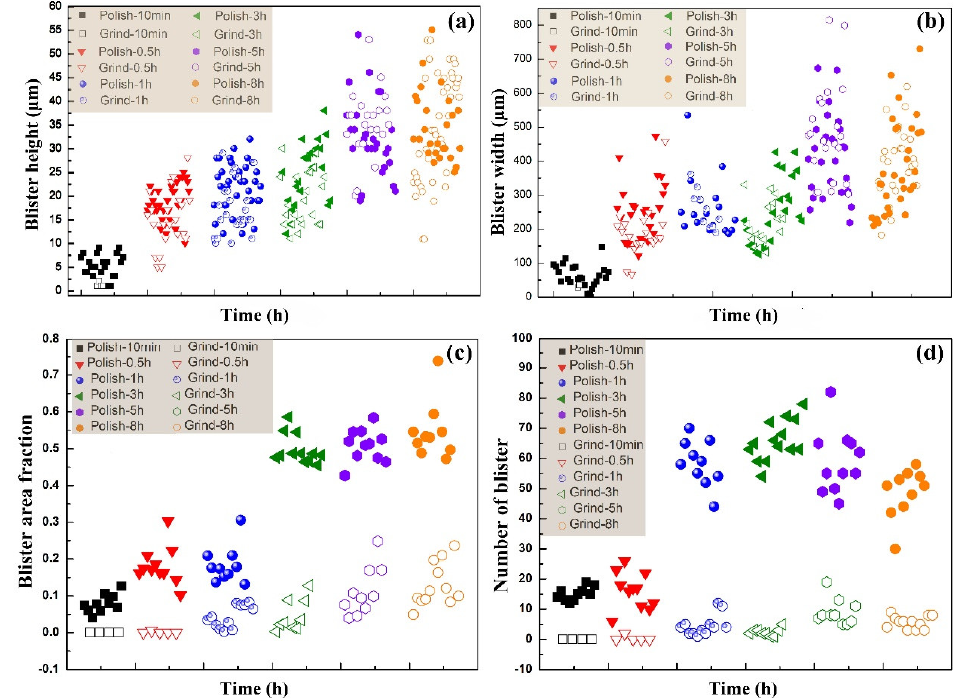
Figure 7. Hydrogen blister parameters of grinded and polished surfaces with various hydrogen charging times. ( a ) Blister height; ( b ) blister width; ( c ) blister area fraction and ( d ) the number of blisters.